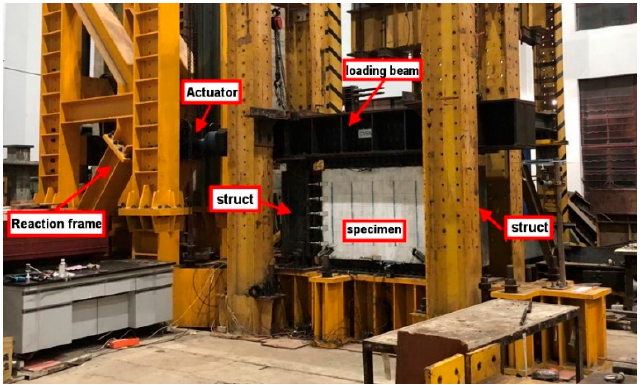
Figure 3. The test setup.